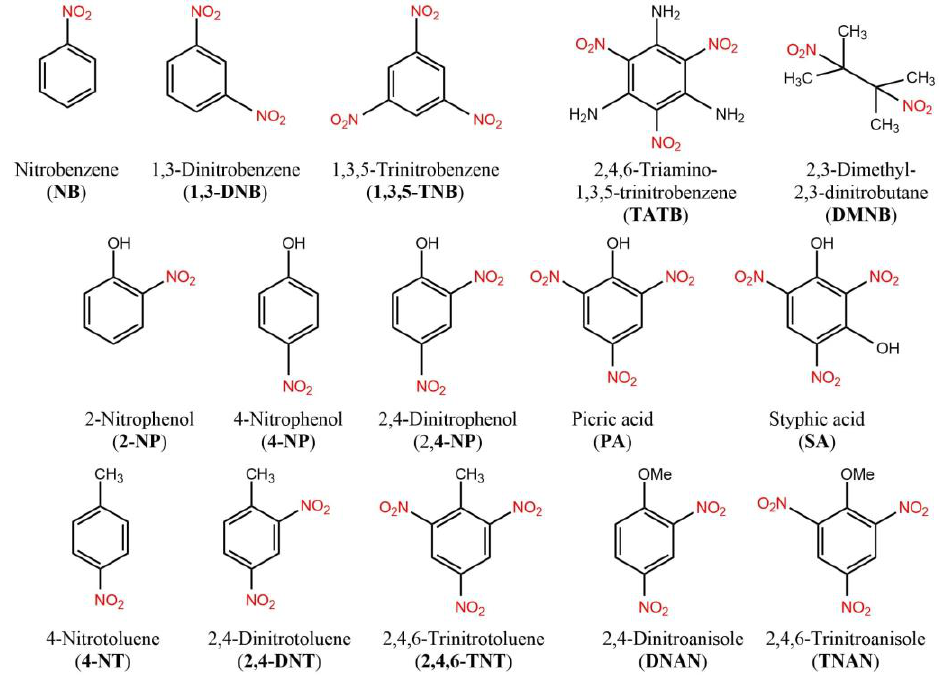
Figure 2. Structures of analytes used to study quenching in acetonitrile solution.